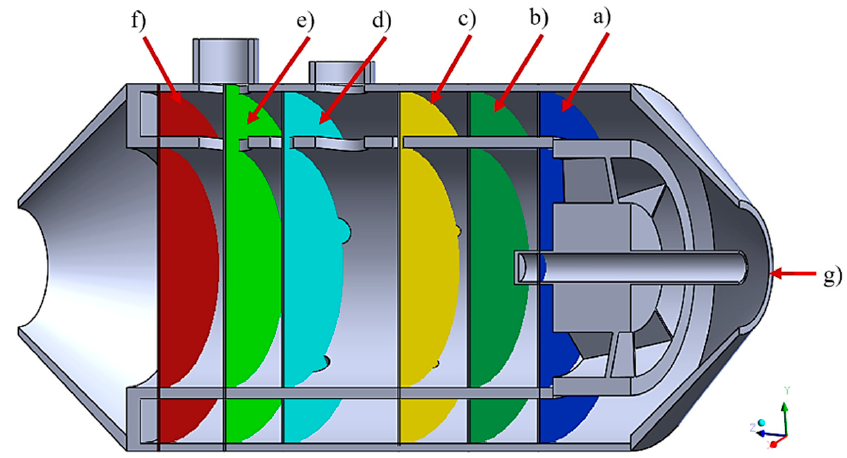
Figure 5. View of xy planes and origin of the combustion chamber: ( a ) plane 1; ( b ) plane 2; ( c ) plane 3; ( d ) plane 4; ( e ) plane 5; ( f ) plane 6; ( g ) origin. Table 3. The z location from the origin for planes.